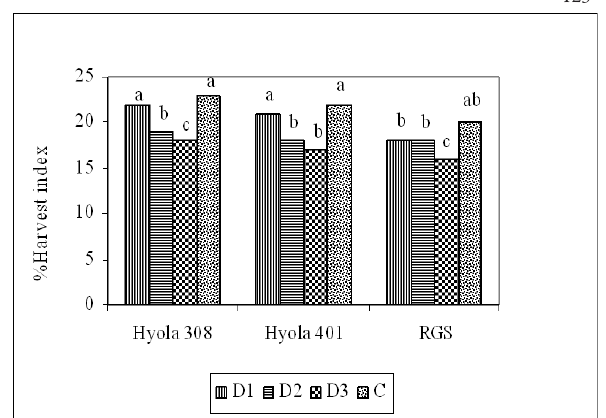
Fig. 5. Interaction of cultivars and water stress on harvest index; Similar letters in each column in terms of 5% statistical level are not significant; D =stress in the early stage of stem elongation to 1 early flowering stage; D =stress in early flowering to early emer- 2 gence of sac; D =stress in early stem elongation stage until early 3 emergence of sacs; C=normal irrigation conditions (Control)